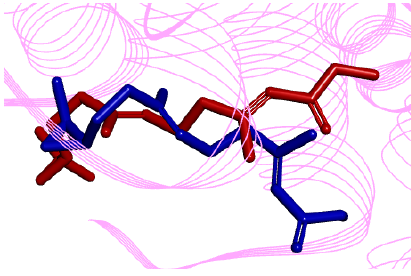
Figure 5. Overlays of crystallographic ligand poses in JH3 (in red) with the calculated pose (in blue). Kenny et al. [64] stated that it does not seem possible to quantify the absolute binding efficiency for compounds objectively. The efficiency can still be defined in a relative way by scaling the affinity differences by the corresponding molecular size differences, and the differences were prioritized for molecular docking for the chitin deacetylase model A. aegypti